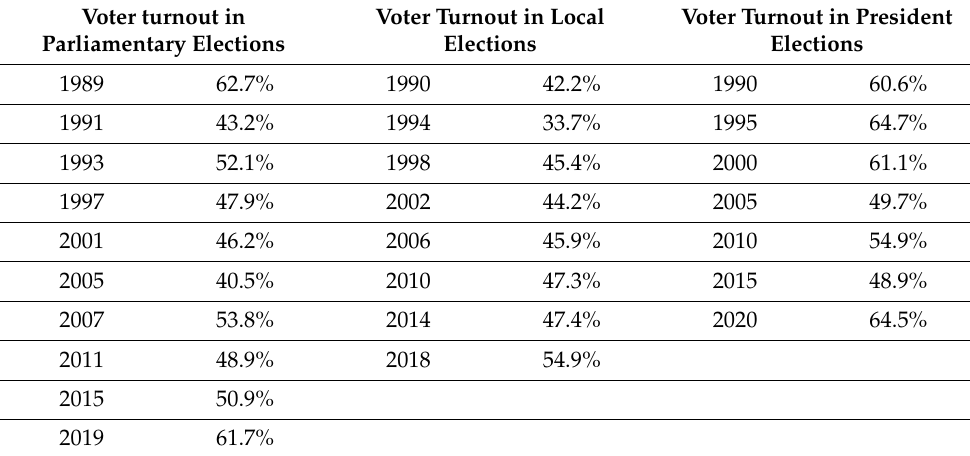
Table 1. Voter turnout in Polish elections